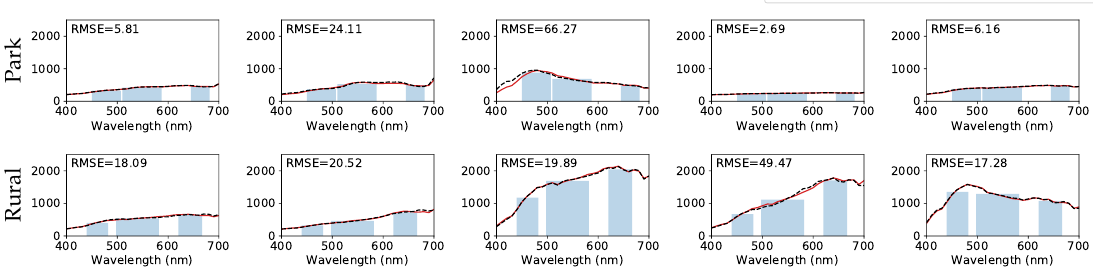
Figure 5. Examples of spectra reconstructions from our method with learned bands. Spectra randomly selected from the test set of Outdoor scenes dataset. The RMSE shown is unnormalized.